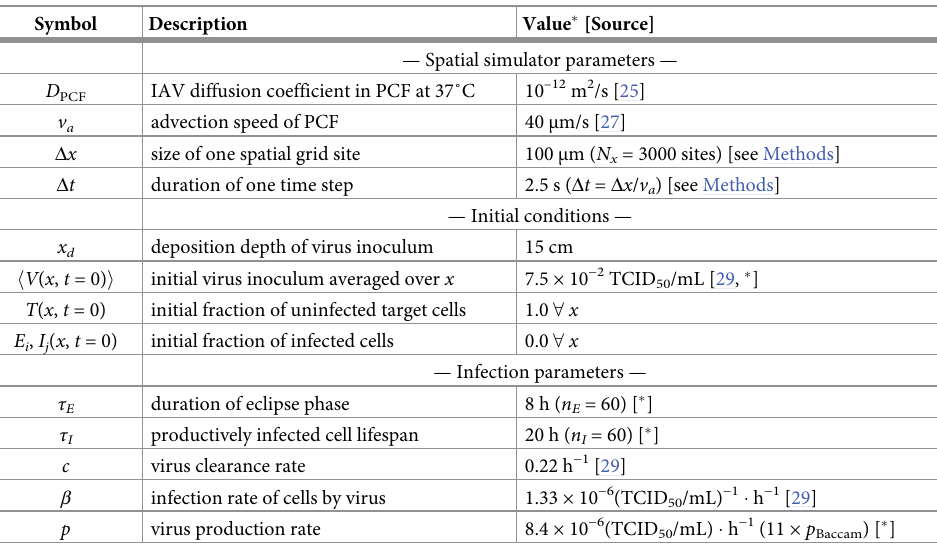
Table 1. Default initial conditions and parameter values.